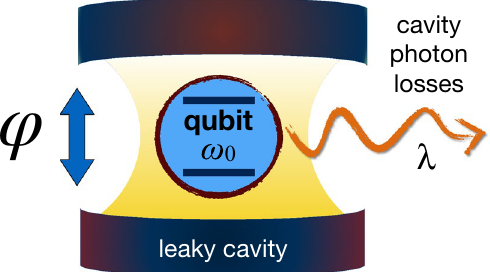
Figure 1. Sketch of a single qubit of transition frequency ω 0 embedded in a dissipative zero-temperature cavity, with spectral width (cid:31) (rate of photon losses). The qubit is initially prepared in a given superposition of its two states, with a relative phase parameter ϕ . This figure was created using Keynote, version 10.3.9 (7029.9.8),